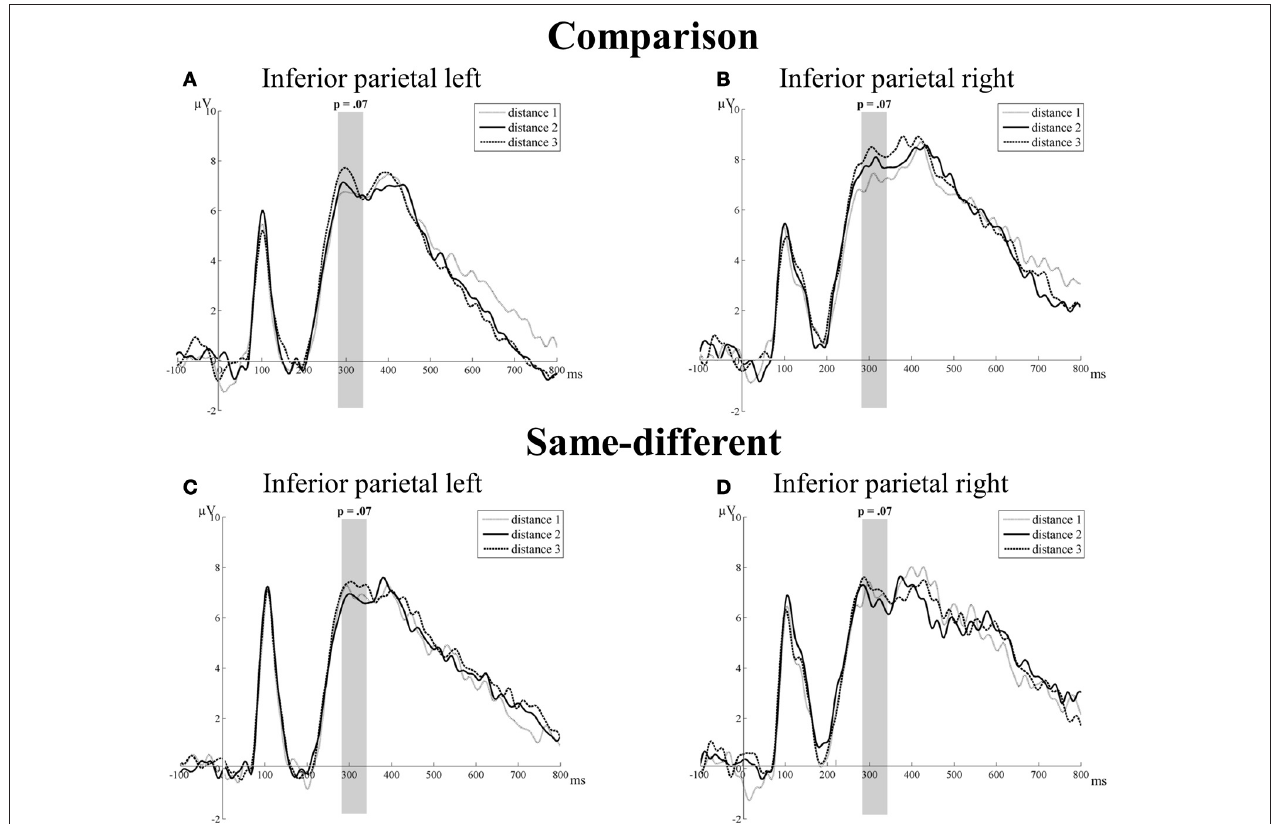
FIGURE 4 | Neural results for the inferior parietal electrode group of the comparison (A and B) and the same-different task (C and D) for the left and right hemisphere. Marginally significant distance effects are indicated with the corresponding p -value. A trend toward